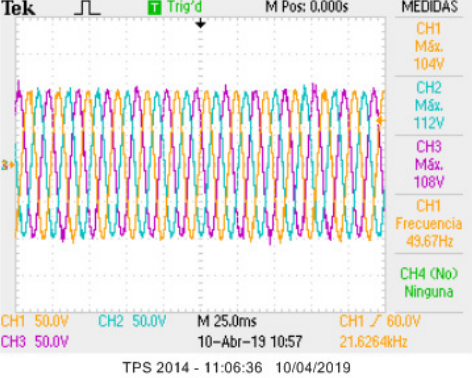
Figure 12. Experimental results: three-phase generated voltage for a resistive load change.